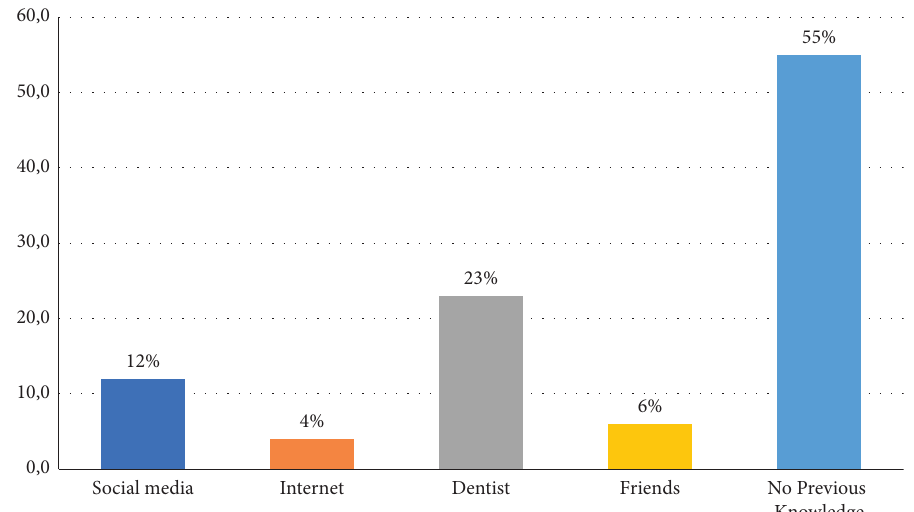
Figure 2: Sources of fuoride varnish knowledge as reported by